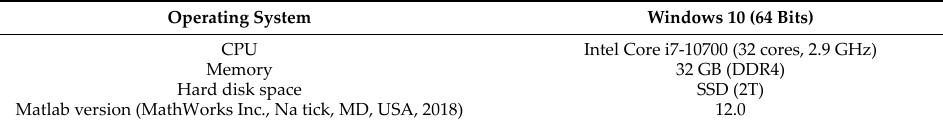
Table 6. Configuration of the